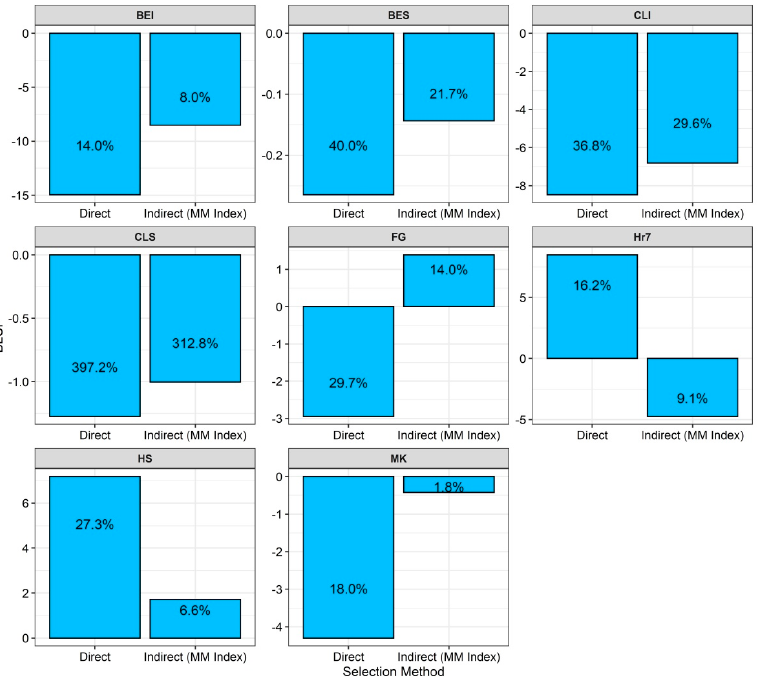
Figure 5. Selection gains for the analyzed traits via direct selection and the use of the sum of ranks (IMM) selection index proposed by Mulamba and Mock [23].